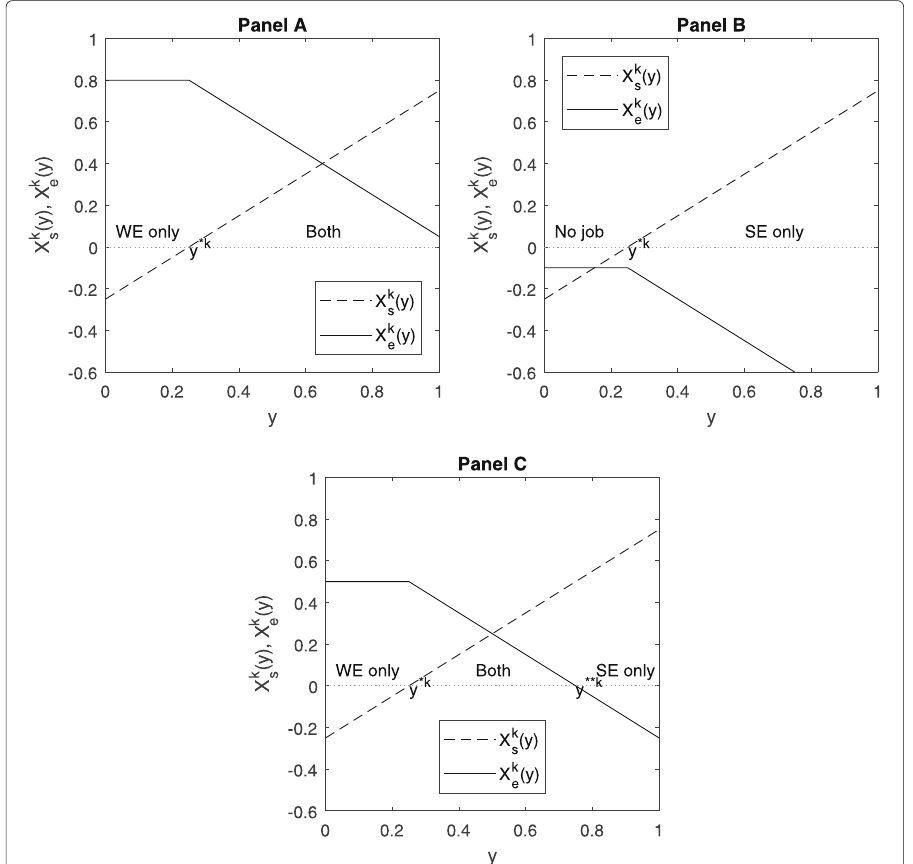
Fig. 2 Possible equilibria and productivity cut-offs. Functions shown are stylised, and not to scale. The upward and downward sloping sections of X k s ( y ) and X k e ( y ) are represented as linear for simplicity. ‘SE’ refers to self-employment. ‘WE’ refers to wage-employment. Panel a : all individuals are willing to take wage job offers. Panel b : no individuals are willing to take wage job offers. Panel c : only low-productivity individuals are willing to take wage job